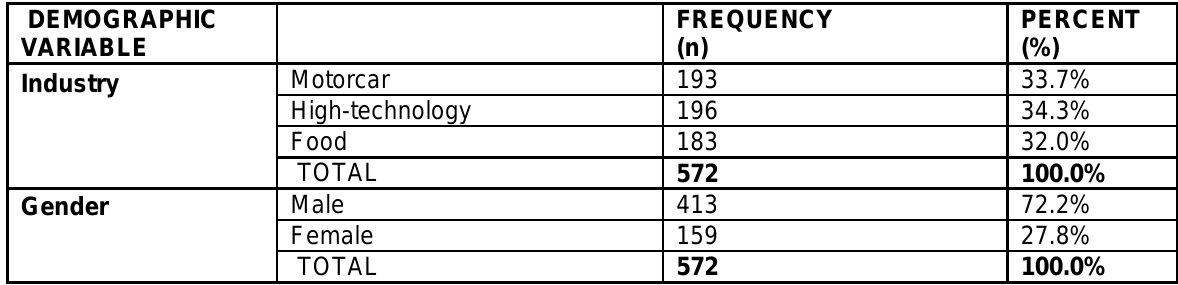
Table 1: demographic composition of the